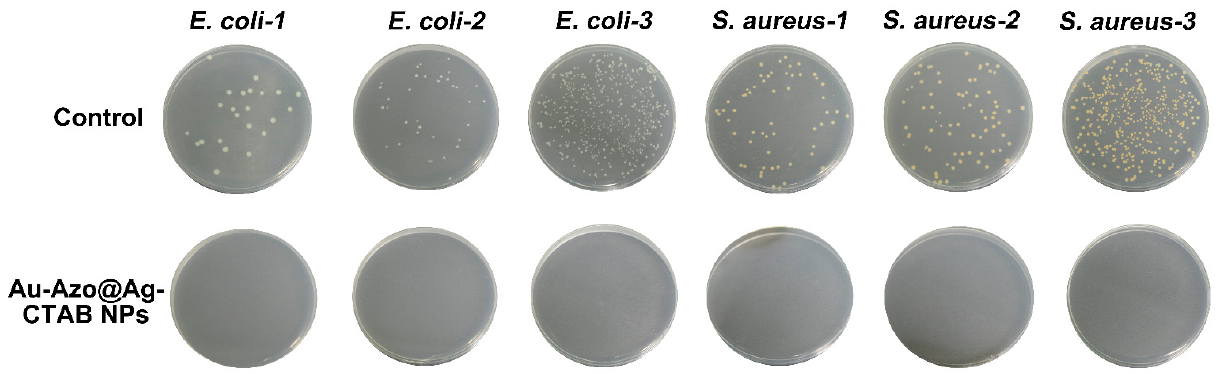
Figure 5. Plate colony images of E. coli and S. aureus in tap water after treatment with Au − Azo@Ag − CTAB nanotags. Table 1. Detection of the concentration of bacteria in tap water based on the culturing method and the constructed method in this work.